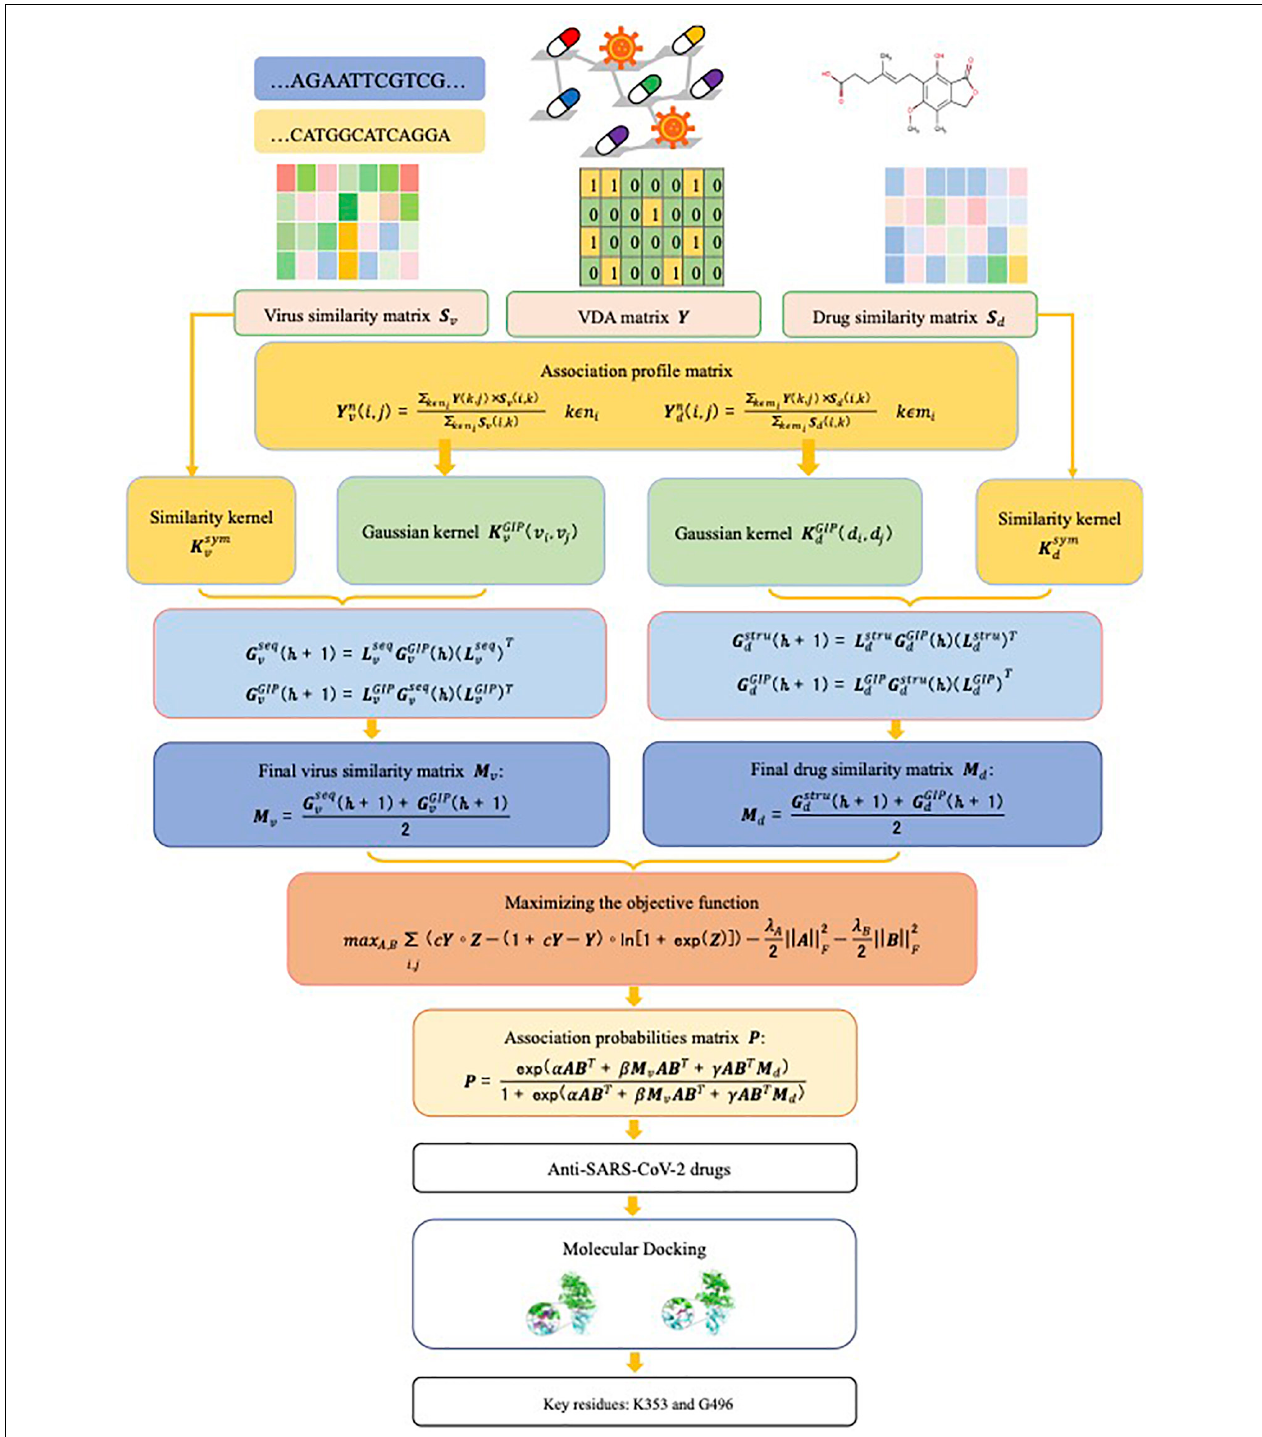
FIGURE 1 | The flowchart of the VDA-KLMF framework.